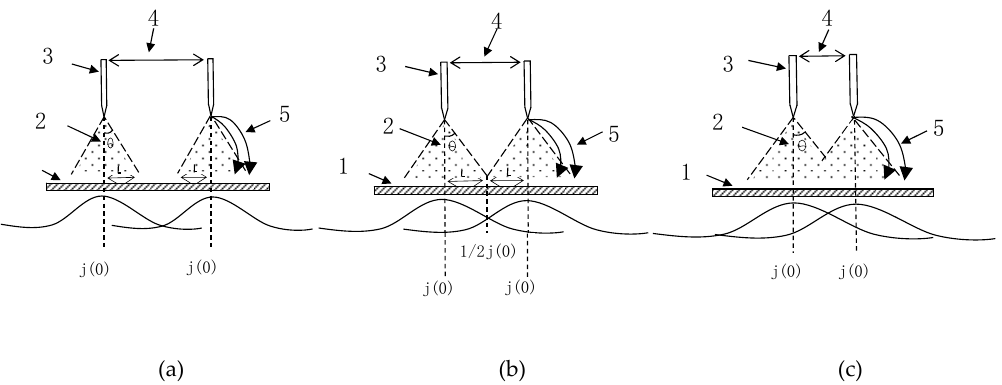
Figure 10. Current density distribution of ions. ( a ) without interference; ( b ) exact distance; ( c ) with interference.1. Ground electrode; 2. electrode distance; 3. emitter electrode; 4. distance between two neighbored electrodes; and 5. field and ionic flow line.